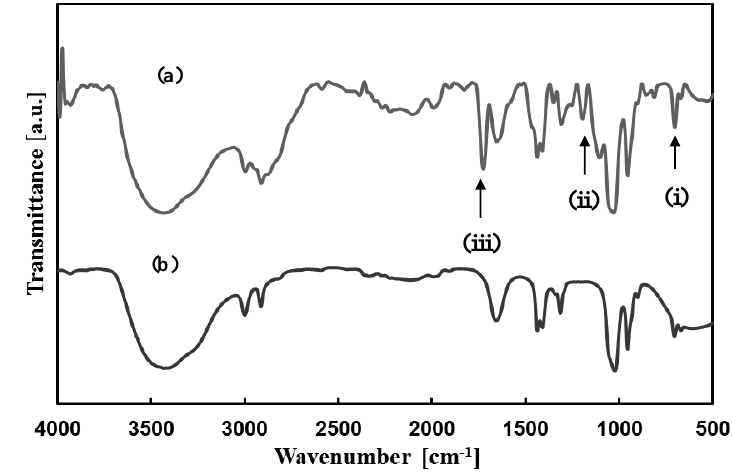
Figure 3. FT-IR spectra of PEI-PEGDA400 reaction system of Case 1 ( a ) before reaction, and ( b ) after reaction, solvent: DMSO, monomer concentration: 30 wt %.